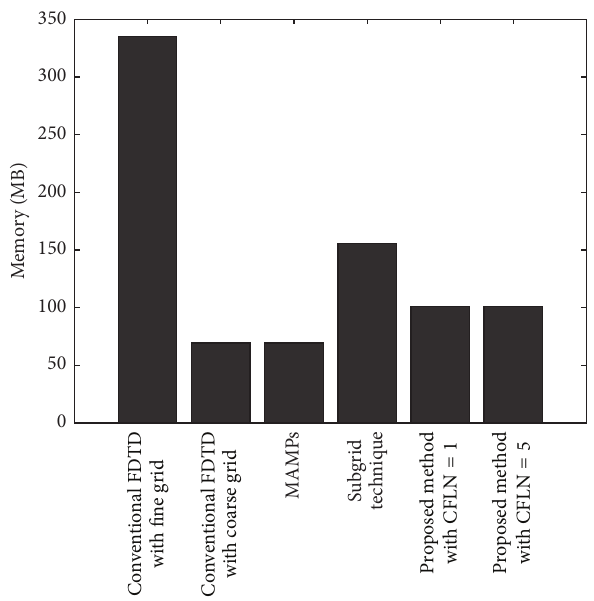
Figure 9: Memory requirement using different